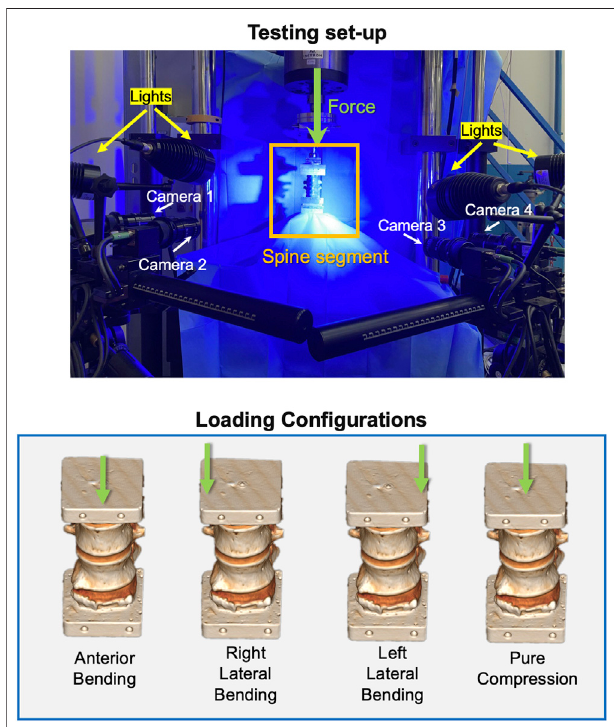
FIGURE 2 | Top: the loading setup and the DIC system. Bottom: the loading con fi gurations applied to the specimens. The green arrows show the vertical force delivered by the actuator: an offset toward anterior, right, or left was used to generate anterior, right, or left